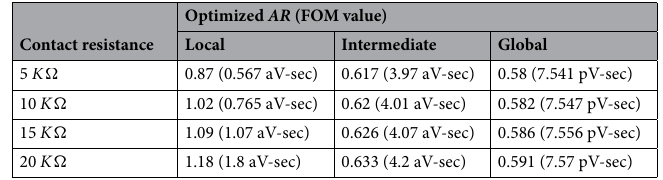
Table 5. Impact of contact resistance on optimized AR and FOM Fecl 3 doped MLGNR interconnects at 7 nm technology node.